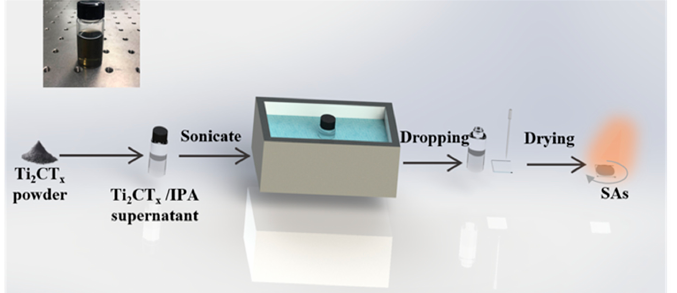
Figure 1. The fabrication process of the transmissive Ti 2 CT x -SAs. Insite: the prepared supernatant in IPA.